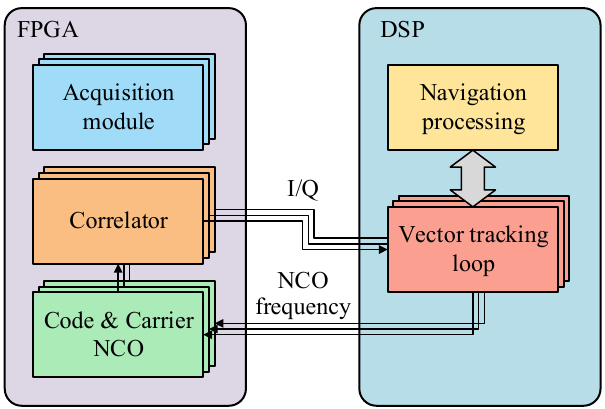
Figure 5. Functional diagram of vector tracking hardware platform.